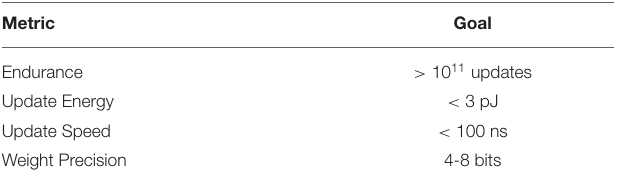
TABLE 1 | List of desired performance metrics for synaptic memory in a system with average fan-out of 1,000, maximum spike rate of 10 MHz, average spike rate of 10 kHz, and spike energy of